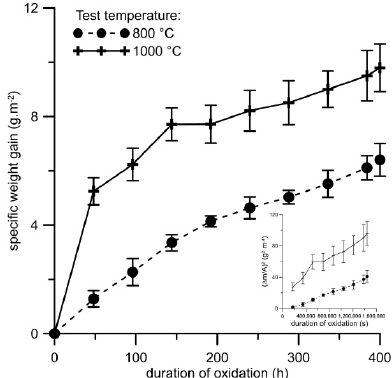
Figure 6. Dependence of the amount of delaminated oxide (g 006 − 2 ) on the duration of isothermal oxidation at 800 and 1000 °C in air for FeAl20Si20 alloy.